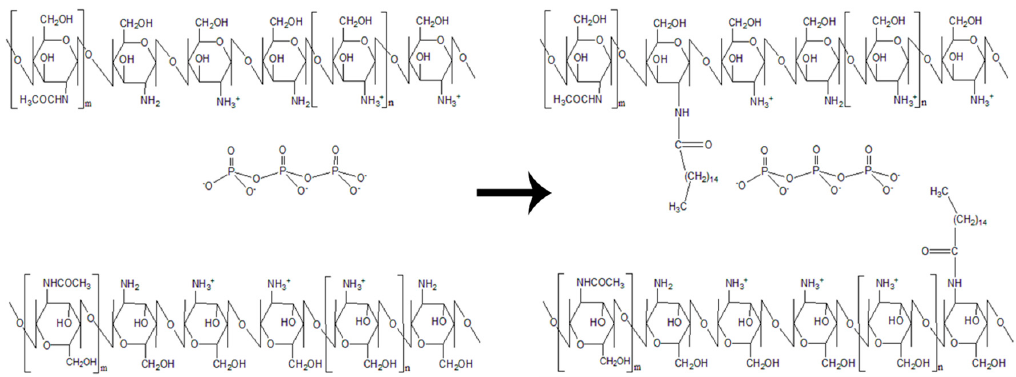
Figure 4. Conjugation of palmitic acid to amine group of chitosan. ( left ) Structure refers to unmodified CNP, and ( right ) structure refers to modified PCNP. “m” and “n” denote repetition of acetylated and deacetylated group of chitosan, respectively.